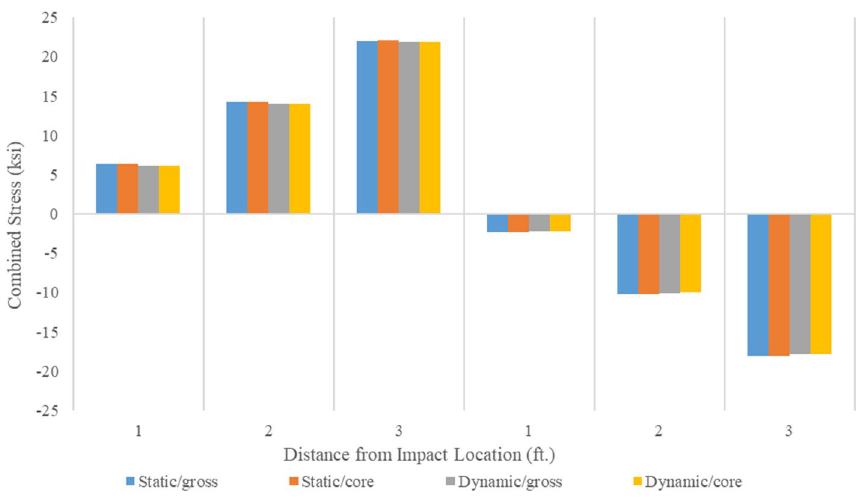
Fig. 11 Combined stresses in column at different fiber